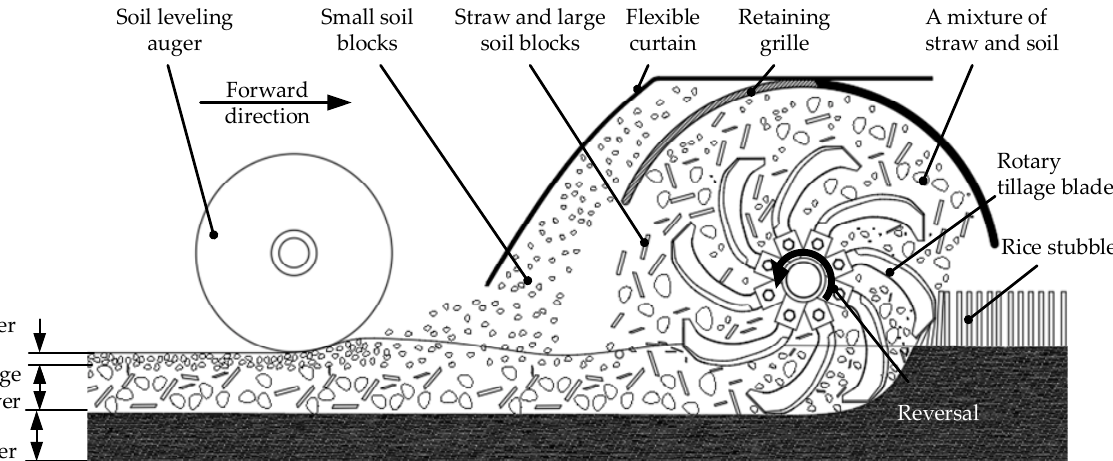
Figure 2. Operation principle of seedbed preparation machine of rapeseed combined